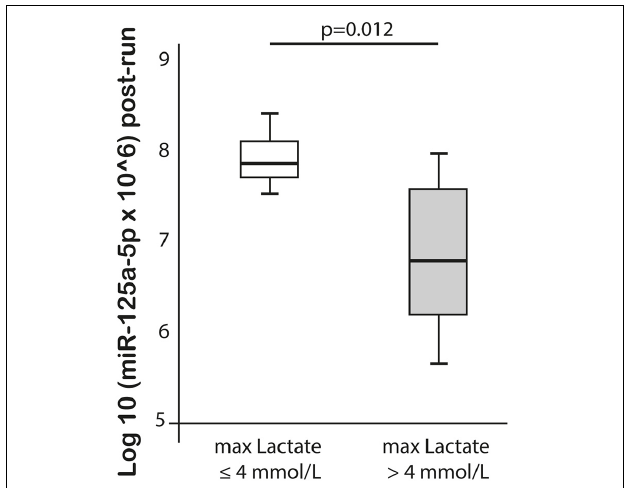
FIGURE 5 | Difference in miR-125a-5p expression after completion of the run in subgroups divided based on lactate concentration.